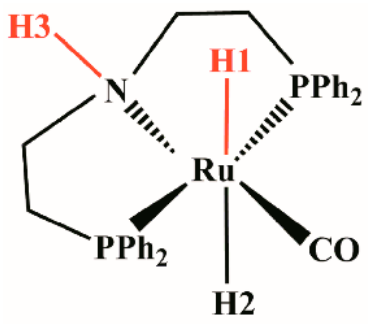
Figure 4. trans -RuH 2 (CO)(dpa).